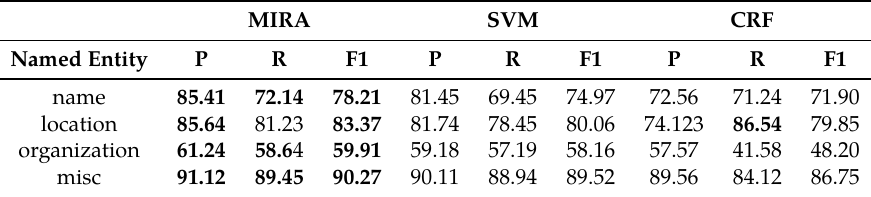
Table 7. Experimental results of each named entity (NE) class in the test set using contextual, word-level, and corpus features. CRF: conditional random field; MIRA: margin infused relaxed algorithm; SVM: support vector machine. P: precision; R: recall; F1: F1-score.